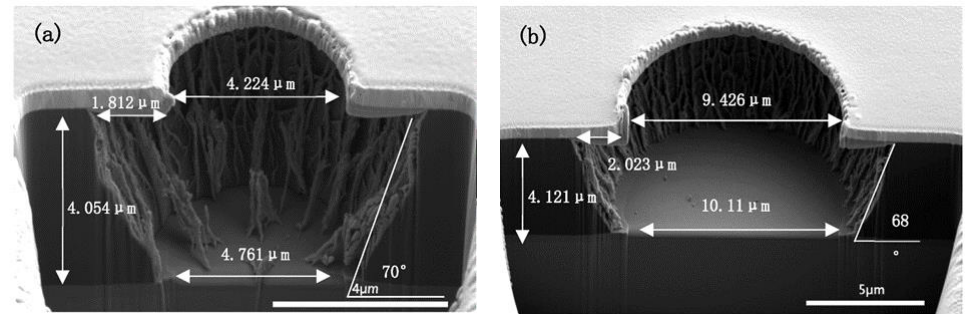
Figure 12. ICP etching of fully cured PI under 2000 W ICP power, 600 W RF power, 10% CHF 3 ratio, 100 sccm gas flow and 3 min. (( a ) the via diameter is 4 μm ; ( b ) the via diameter is 9 μm )